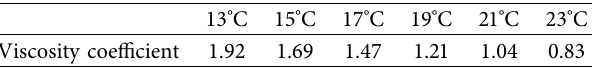
Table 1: Measured values of viscosity coefficient at different temperatures.